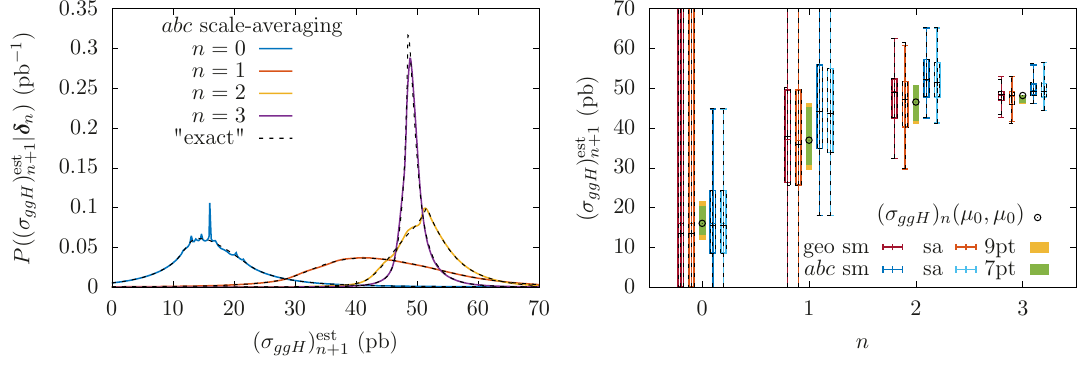
Figure 15 . Left: the coloured lines show the probability distributions for the abc -model at different orders using the sa-prescription and the 3-point Gauss-Legendre quadrature on µ { 1 / 2 , 1 , 2 } . The black dashed line indicates the “exact” numerical integration in the interval with F = 2 . 45 . Right: the CIs for the geometric and abc models at different orders using the sm- and sa-prescriptions using the Gauss-Legendre quadrature. The result of the “exact” numerical integral are overlaid using black dashed lines. For comparison we also include the 9-point and 7-point variation